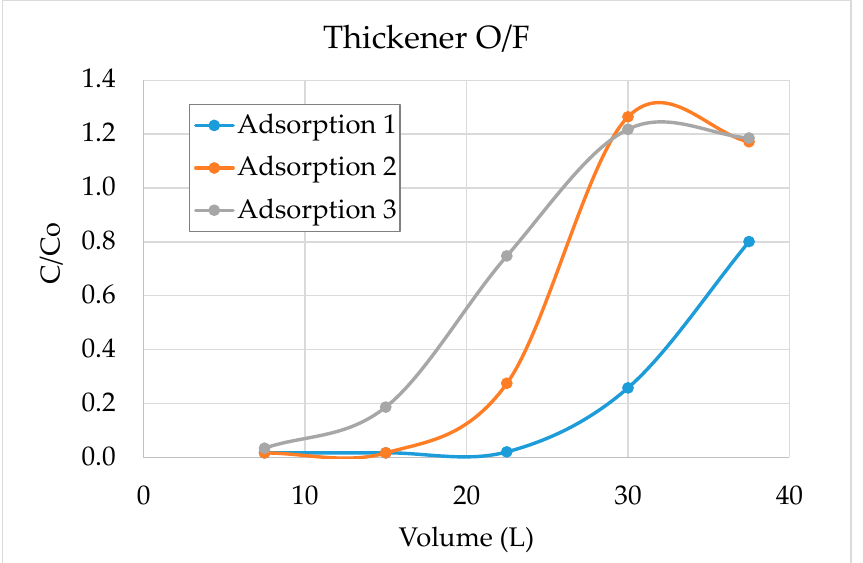
Figure 13. Breakthrough curves of the sulfate ion for the three adsorption experiments conducted on the Thickener Overflow.